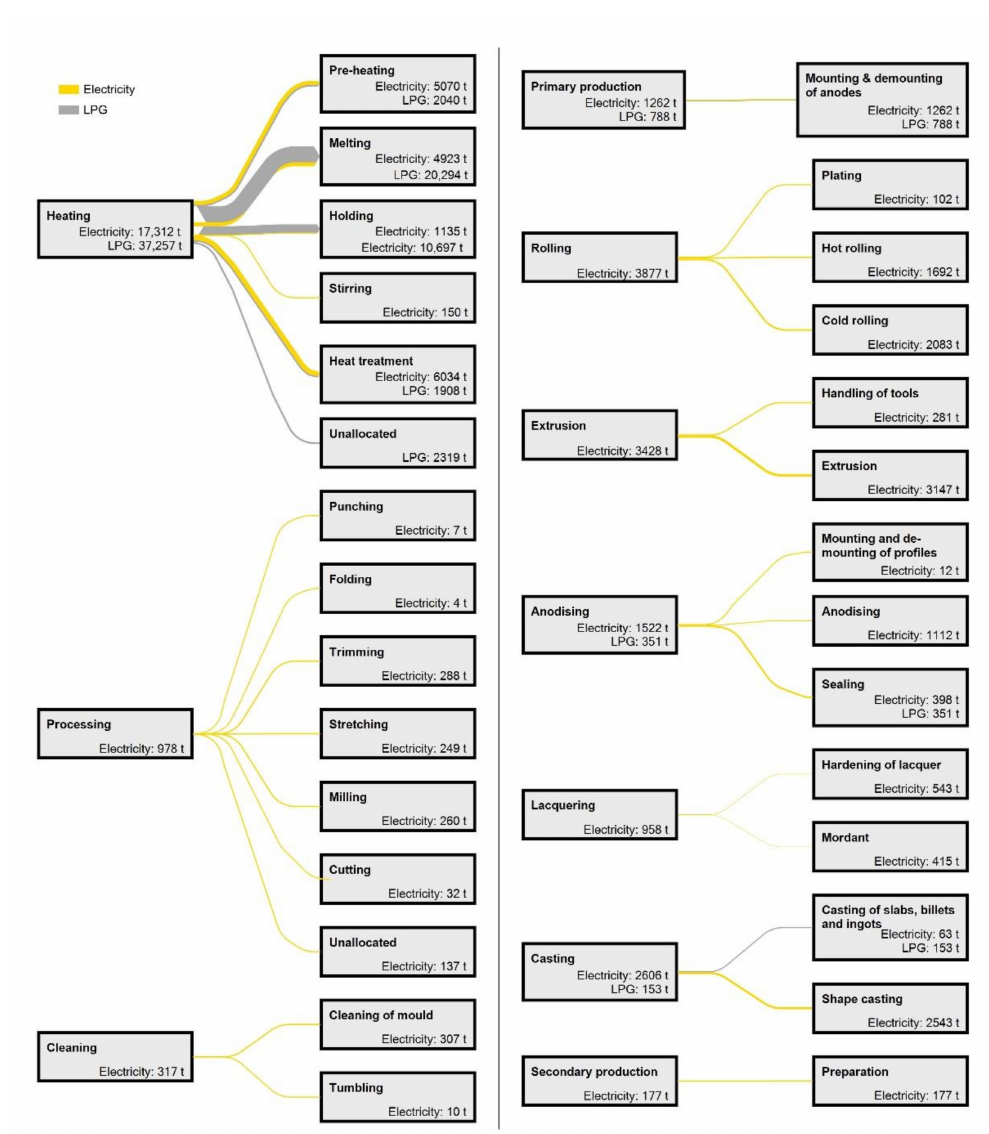
Figure 13. The GHG emissions of the aluminium industry and two aluminium casting foundries in Sweden for the main categories within the production processes, divided into the processes included within each category. Electrolysis is excluded. Processes occurring at several companies in the supply chain have been combined into one entry each. The average mix perspective and the emission factors in Table 1 were used here, as described in Section